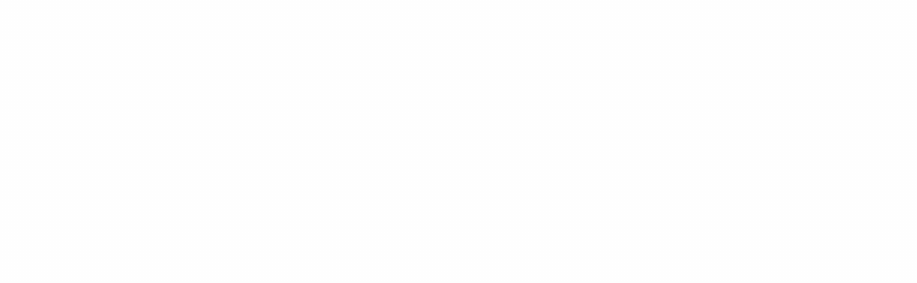
Fig. 4: Source estimates. The images have been selected to illustrate those main source locations which are likely to give rise to the differential effects, and which have been consistently identified across subjects, i.e. occipital (V; dipolar sources), left temporal (T), left lateral frontal (F), and right posterior parietal (P). These source areas are consistent in at least three out of the four subjects for which MRIs were available. At long latency, other areas may become strongly active but there is considerable inter-subject variability. The putative functional significance has been indicated. It is noted that due to variability not all generators mentioned in the text are visible. For the purpose of presentation, each view has been rotated by a few degrees